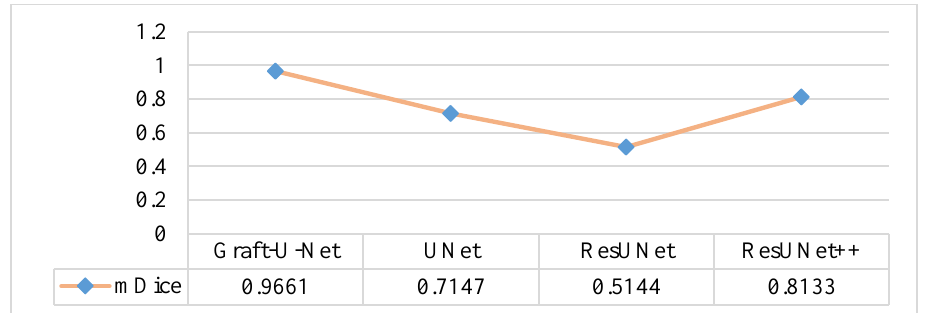
Figure 7. Comparison of Graft-U-Net on Kvasir-SEG dataset in terms of mDice. The results of Graft-U-Net (0.8245) in terms of mIoU are compared with the pre-study models of UNet (0.4334), ResUNet (0.4364), and ResUNet++ (0.7927). The comparison result of mIoU is depicted in Figure 8.